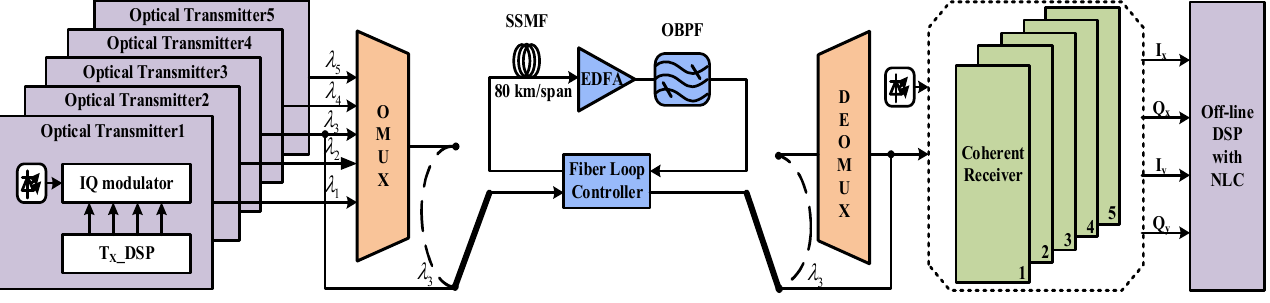
Figure 6. 28/85 GBaud PDM-16/64QAM SC and 5-channel WDM numerical simulation platform.